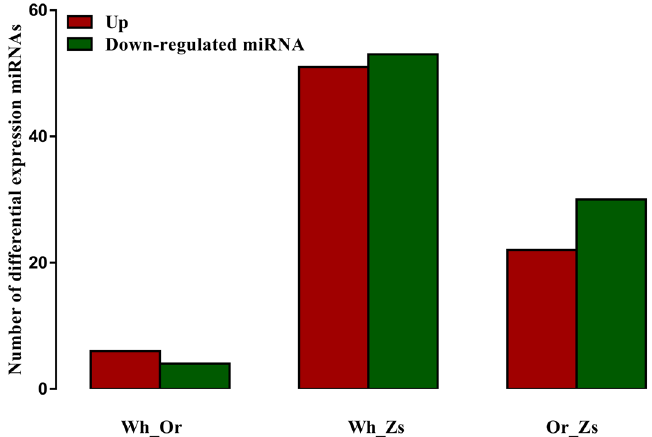
Figure 2. Differentially expressed miRNAs (DEMs) in three pairwise comparison groups. Red and green indicate up- and down-regulated miRNAs, respectively.